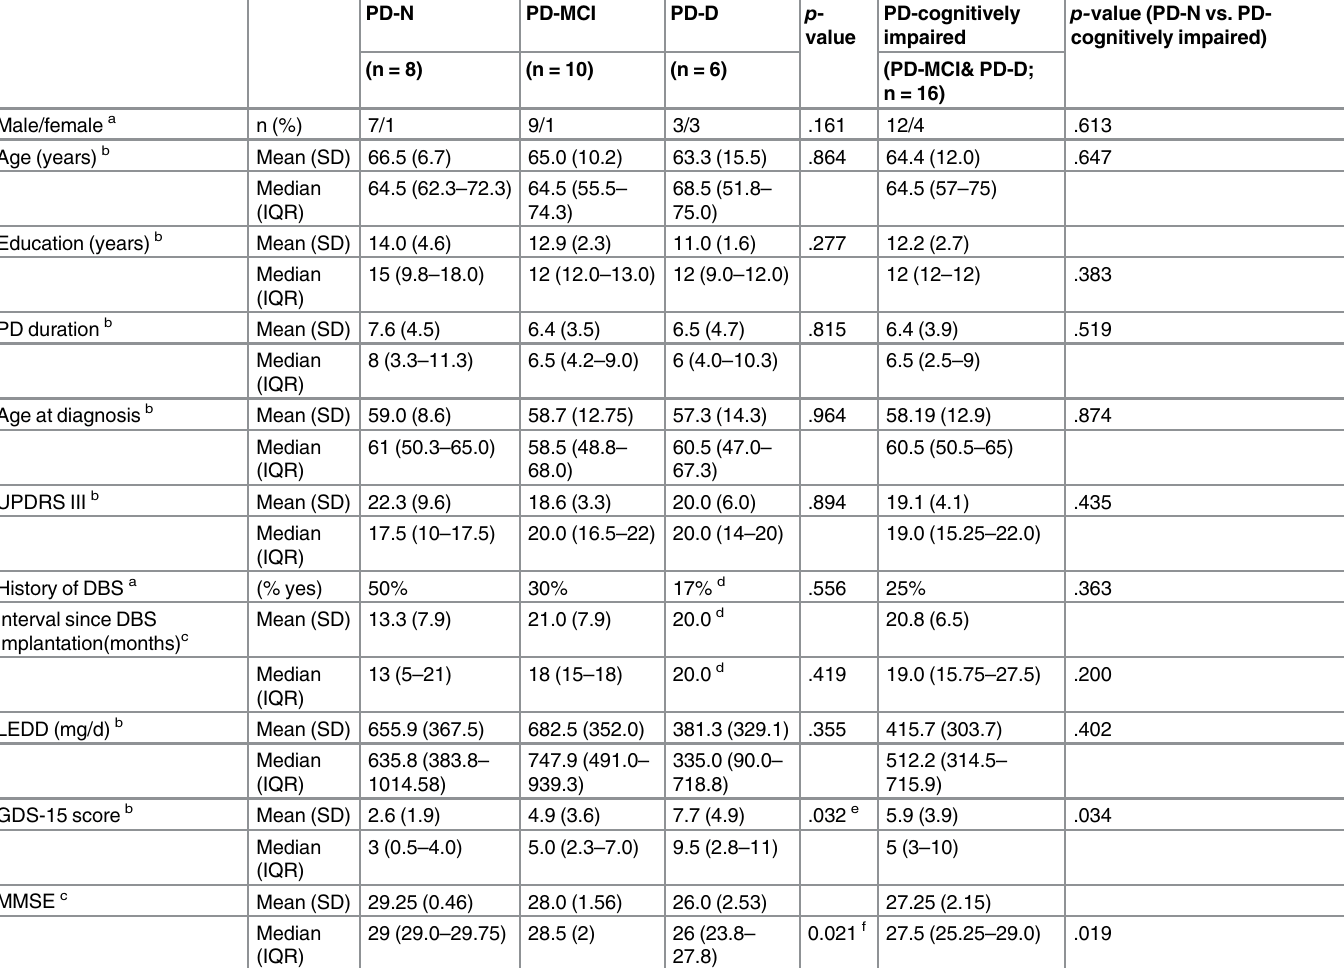
Table 4. Demographic and clinical characteristics of all diagnostic groups in study